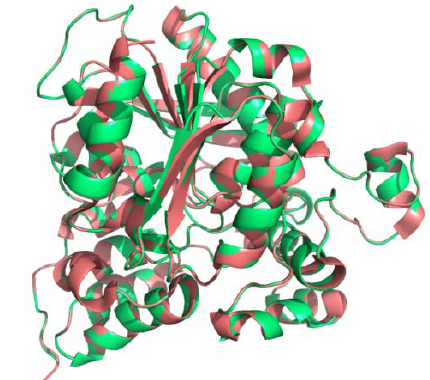
Figure 6. Stereo ribbon representation of the predicted 3D structure model of cLIPA (red) and the superimposition with dGL (green). The 3D structure model of cLIPA was predicted using Swiss-model server.